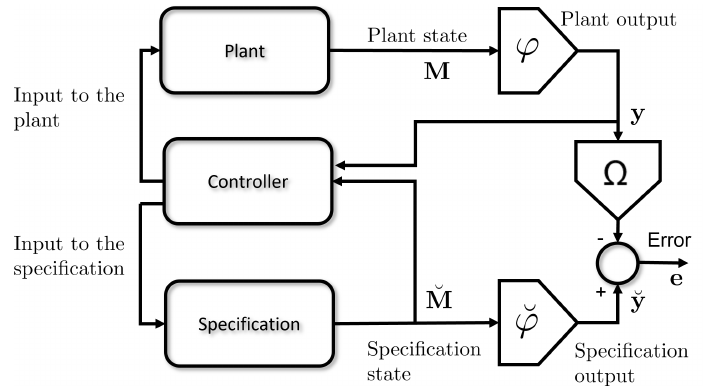
Figure 2. Regulation control scheme for IPN